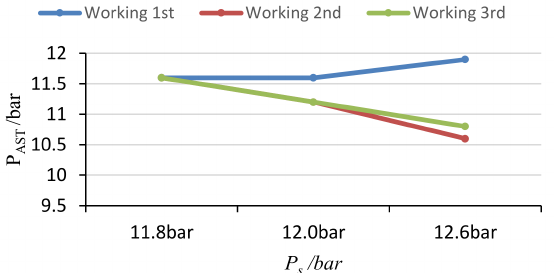
Figure 10. Comparison of pressure drop from Conditions 1 to 3 (experiment